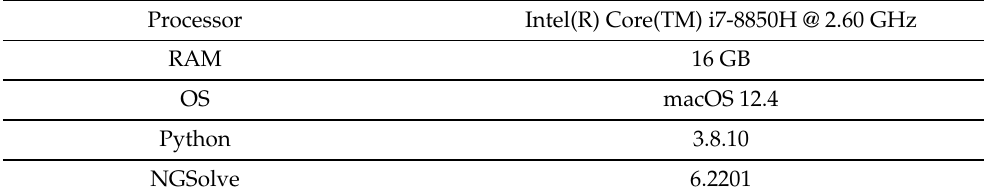
Table 2. Computer configuration with installed environments.